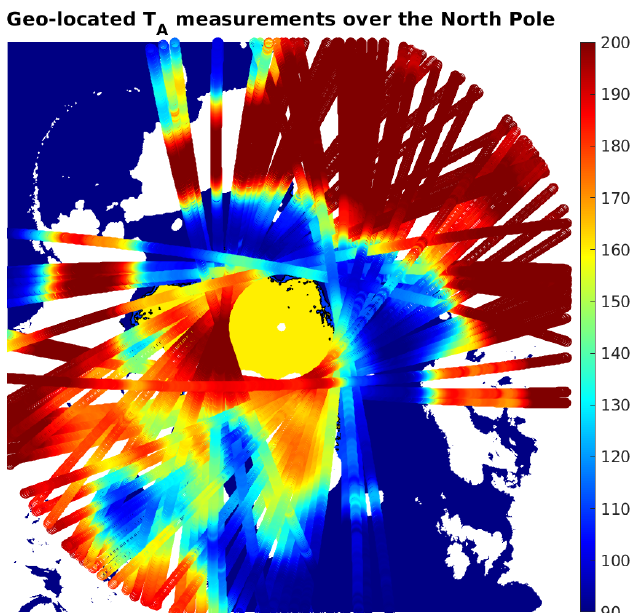
Figure 4. FMPL-2 calibrated antenna temperature ( T A ) (K) over the North Pole overlaid with OSISAF SIE product (in yellow at the